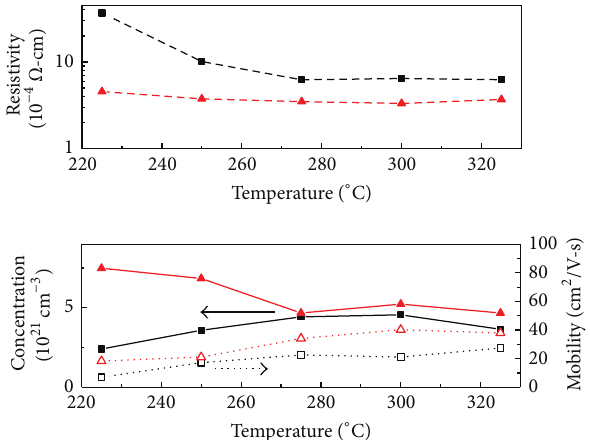
Figure 4: The electrical property of the sputtered AZO film versus the substrate